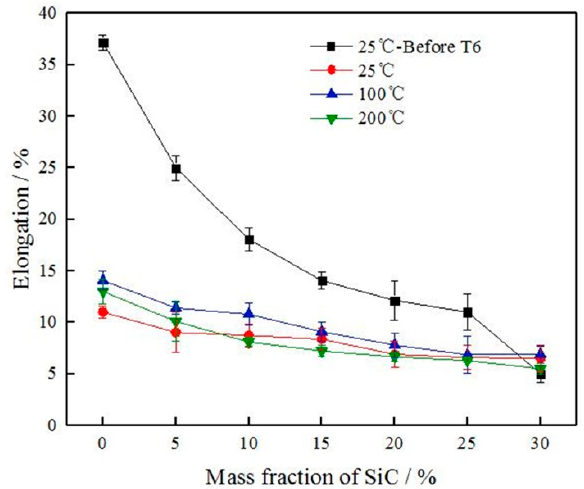
Figure 10. The effect of T6 treatment and test temperature on the elongation of SiC p /6061Al composites.